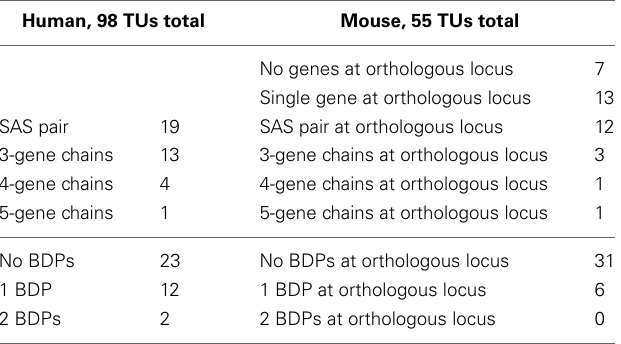
Table 2 | Extent of mouse gene structure conservation for 37 manually annotated human sense-antisense gene